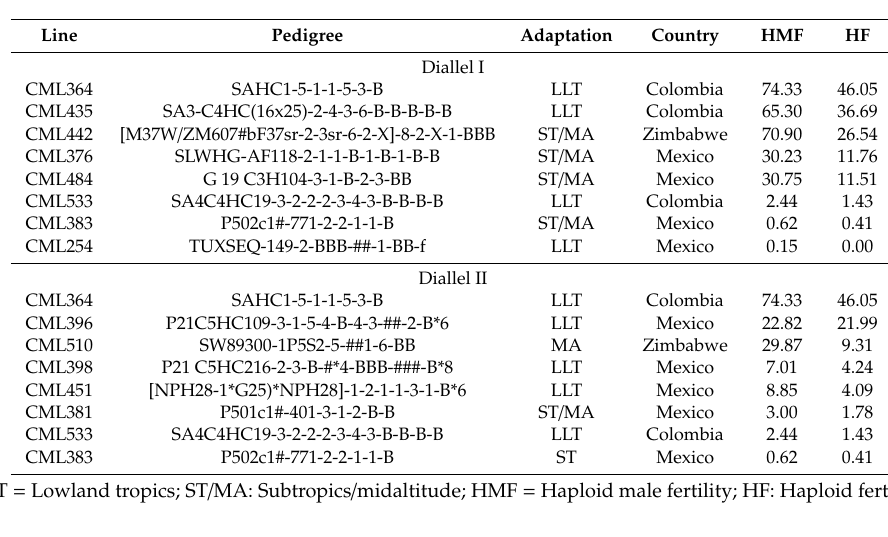
Table 1. Haploid male fertility (HMF) and haploid fertility (HF) of maize lines used in this study expressed in %. The pedigrees, adaptation and country where the lines were developed are also indicated.